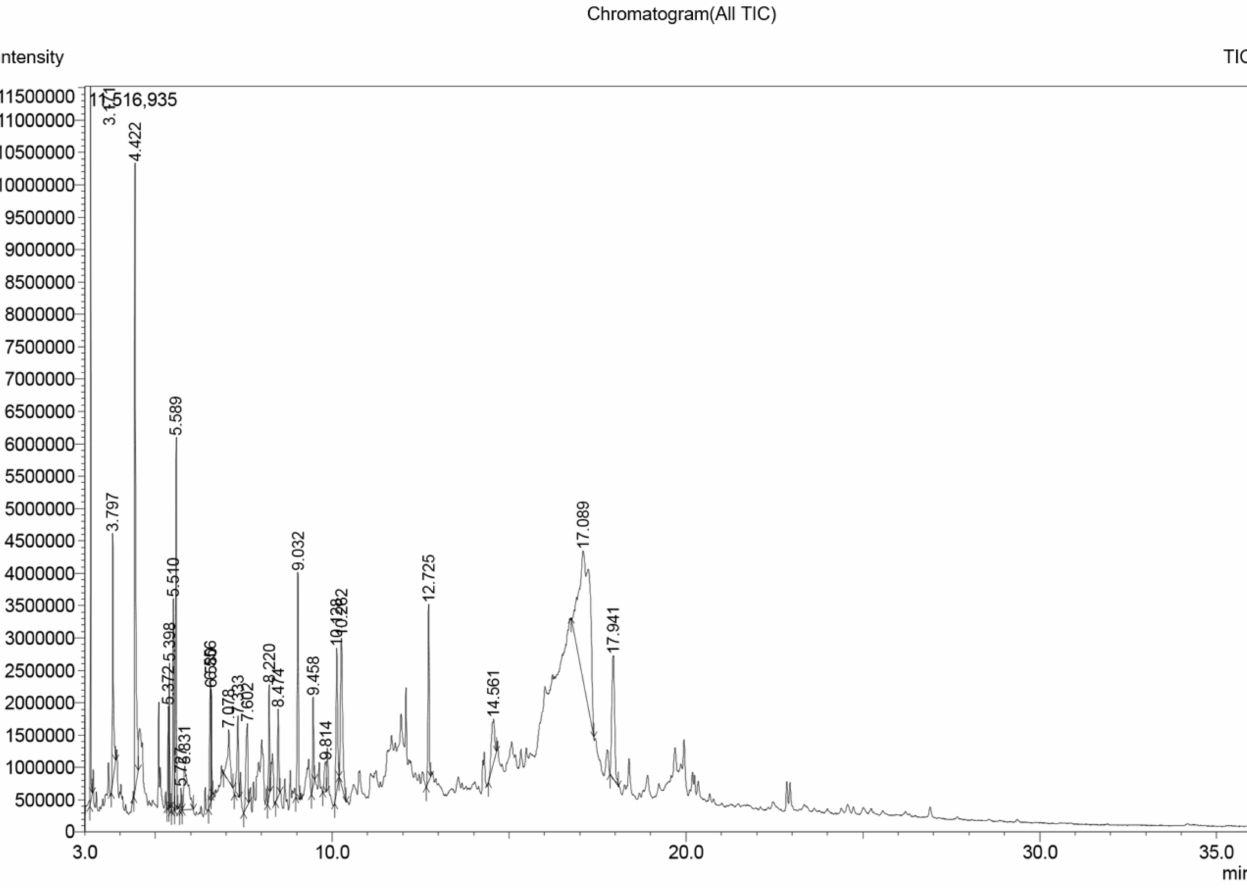
Figure 7. GC–MS chromatogram of crude extract of G. applanatum